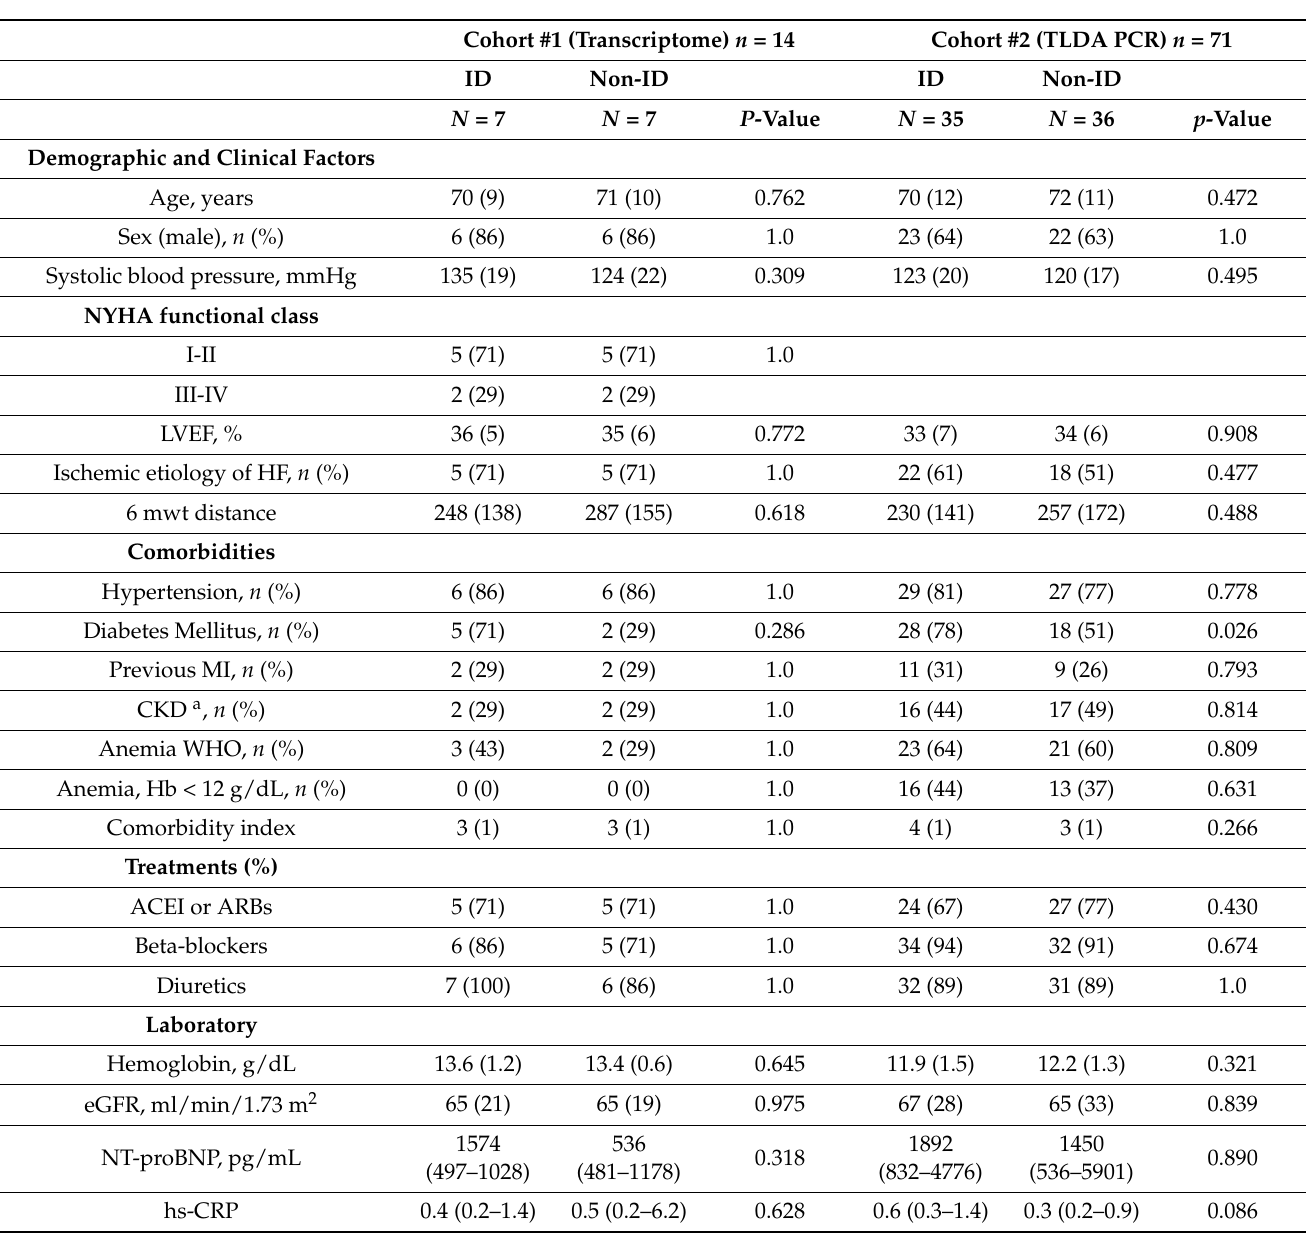
Table 1. Characteristics of cohorts included into the study. Cohort #1 ( n = 14, transcriptome analysis), Cohort #2 ( n = 71,